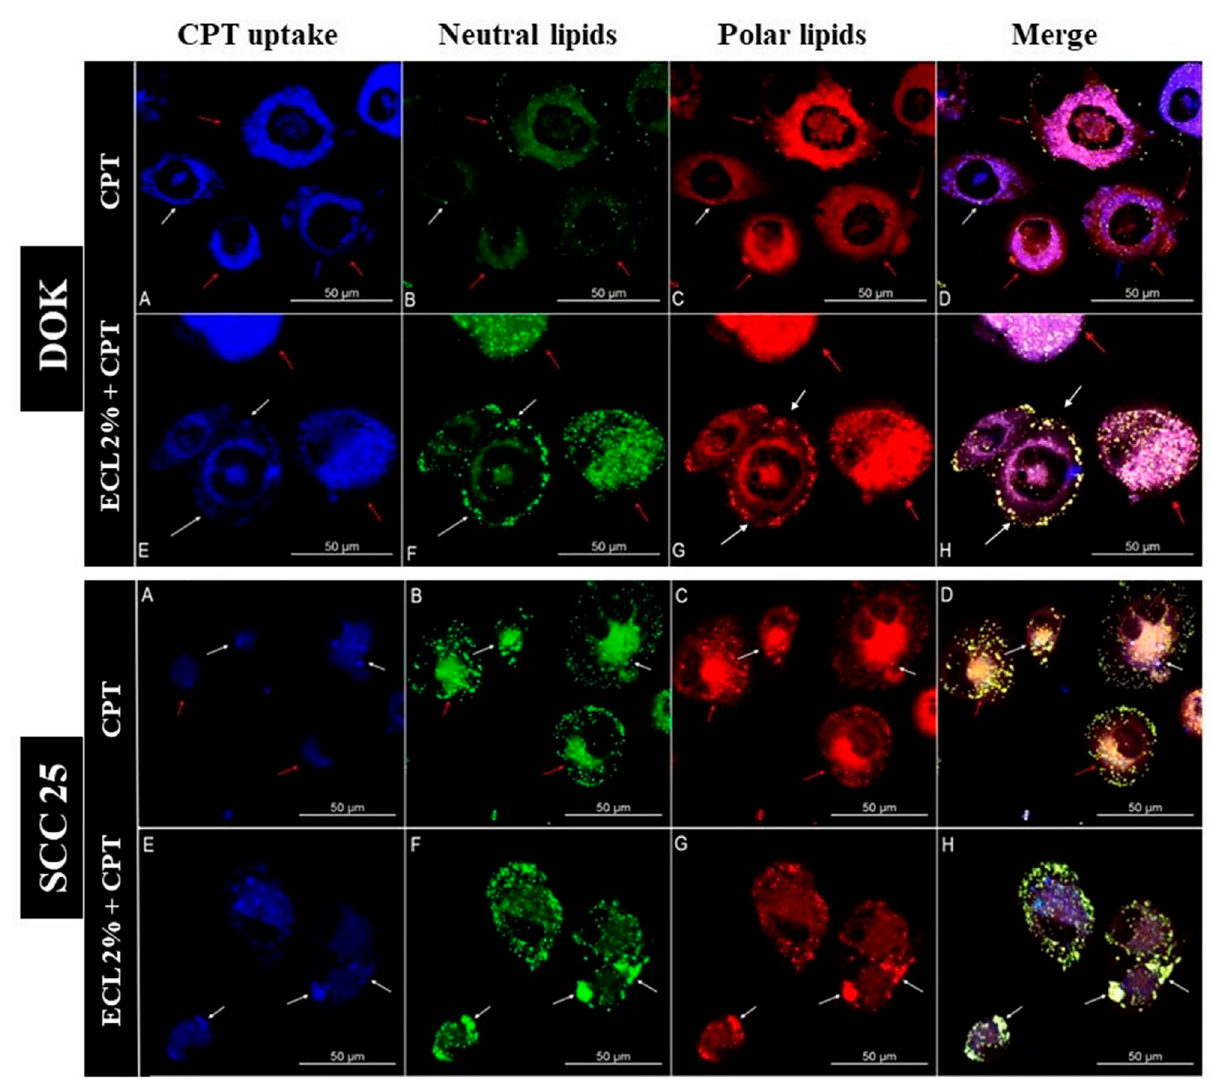
Figure 6- Cell double staining of CPT and 2% ECL of 36-h C. albicans biofilms with Nile Red and high-resolution CLSM. DOK cells (upper panel). CPT detection (A - blue panel white arrows). Nile Red neutral lipids (B - green panel). Nile Red polar lipids (C - red panel). Co- localization of CPT and LD (D – merged panel, white arrows) (n=6). SCC 25 cells (down panel). CPT detection (A – blue panel, white arrows). Nile Red neutral lipids (B - green panel). Nile Red polar lipids (C - red panel). Co-localization of CPT and LD (D - merged panel, white arrows) (n=6). Red arrows show no co-localization between CPT and LD. White arrows show a positive co-localization between CPT and A compared to E – white arrows). These aggregates showed a positive CPT-LD co-localization (Figure 6.